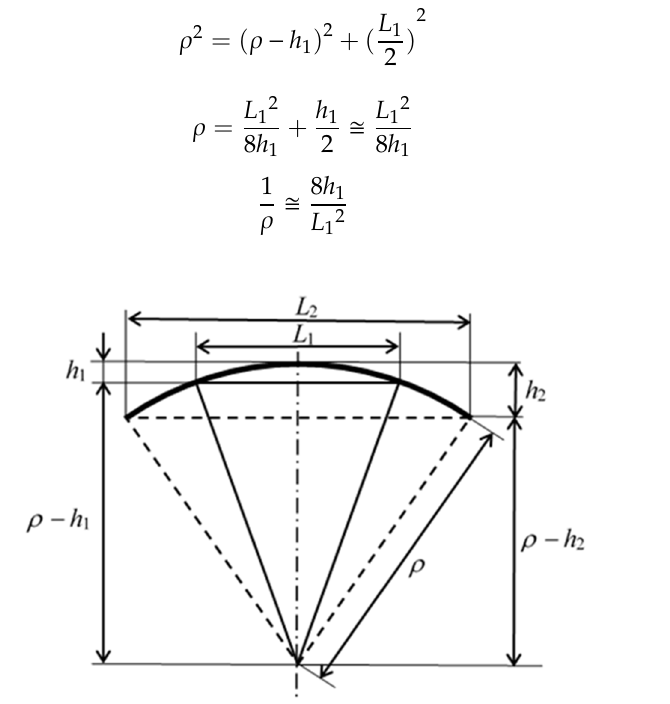
Figure A1. Schematic diagram of radius of curvature and arc height.